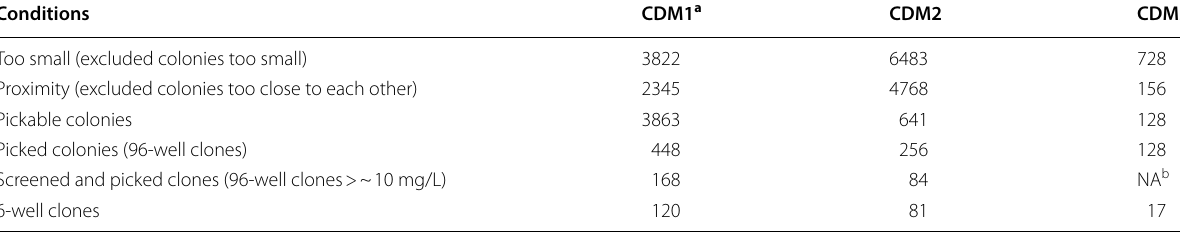
Table 5 Summary of ClonePix2 cloning results